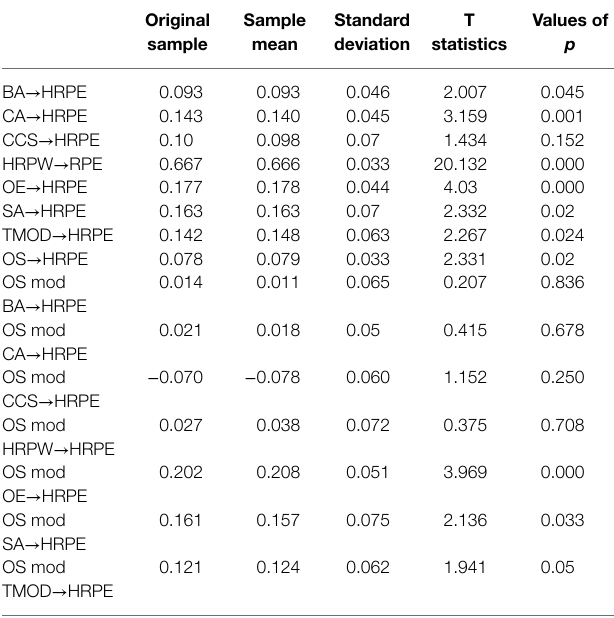
TABLE 3 | Findings of the structural